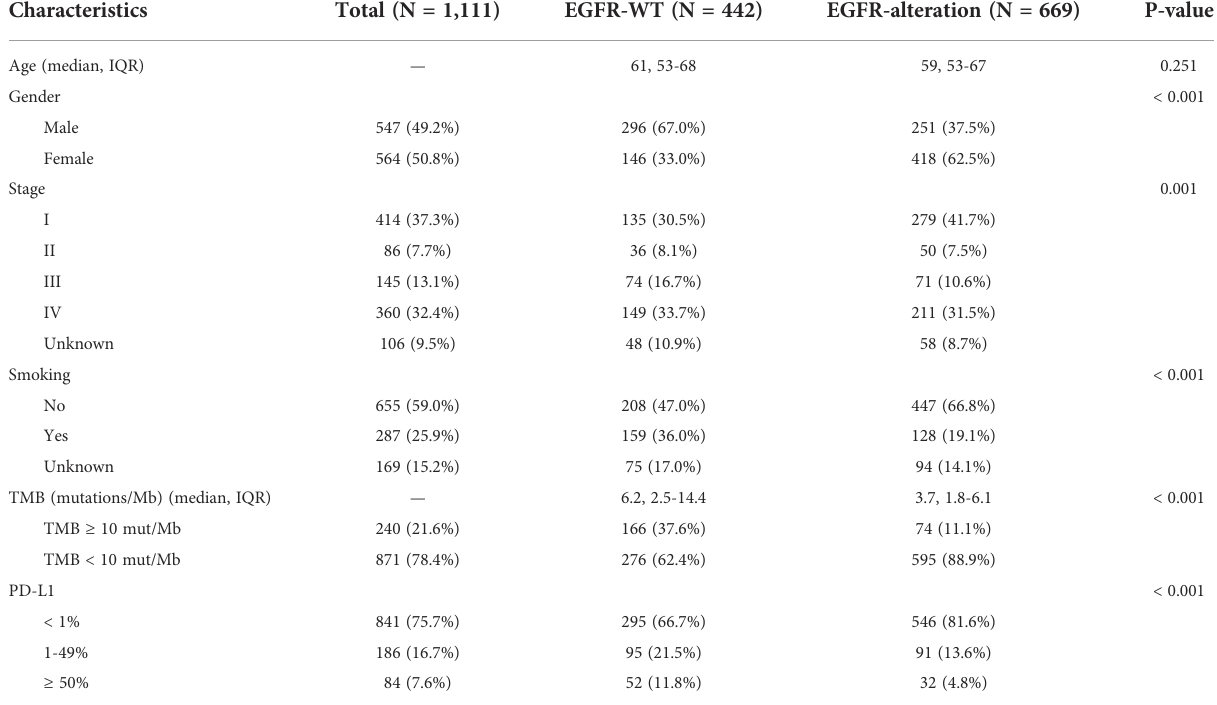
TABLE 1 Baseline characteristics for the 1,111 NSCLC